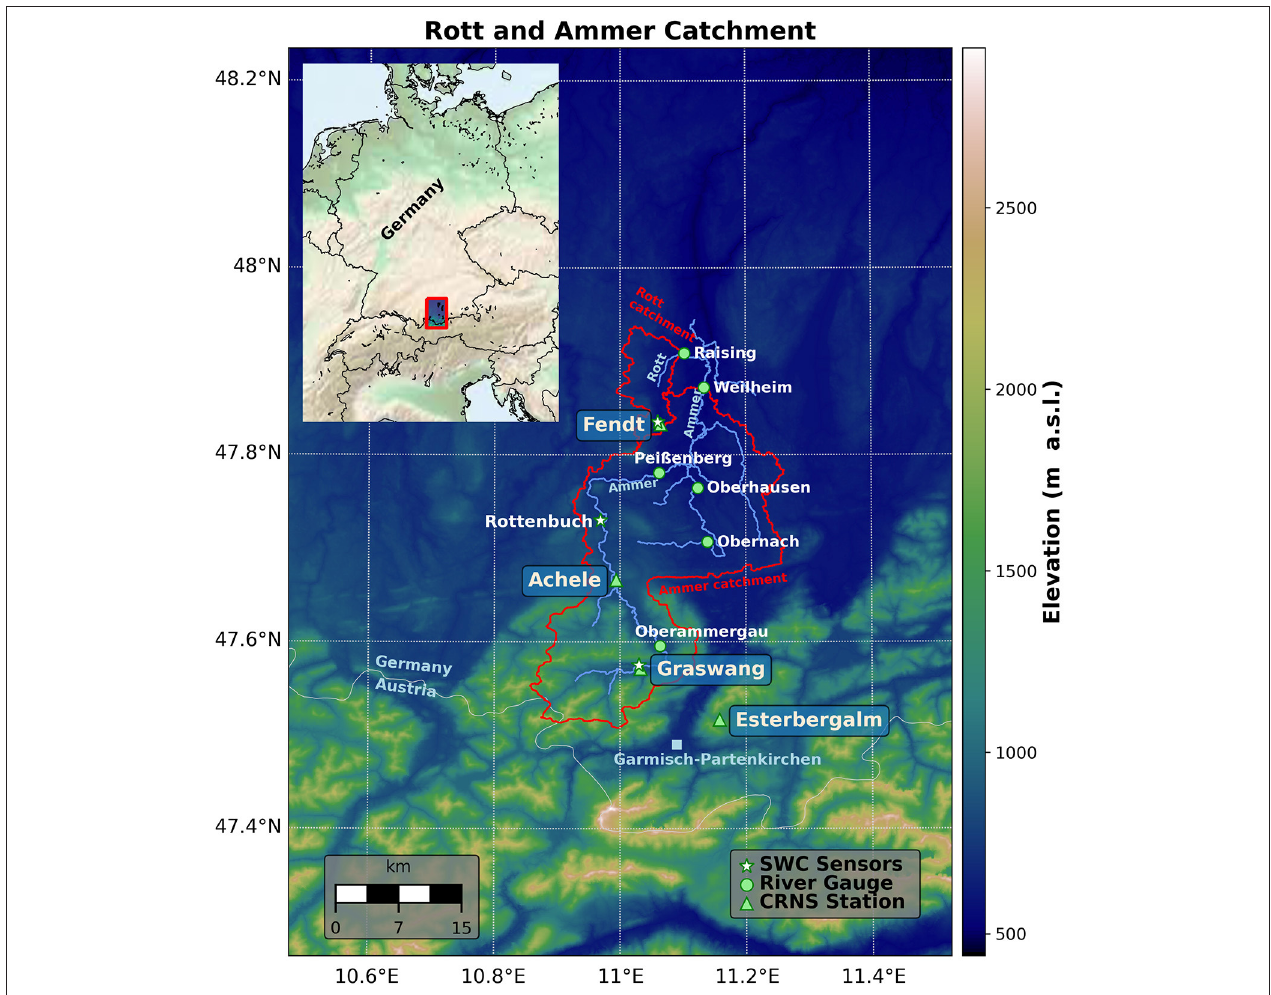
FIGURE 1 | Location of the study area, the TERENO Pre-Alpine Observatory sites and river gauges. The elevation map was derived from the SRTM 30 meter